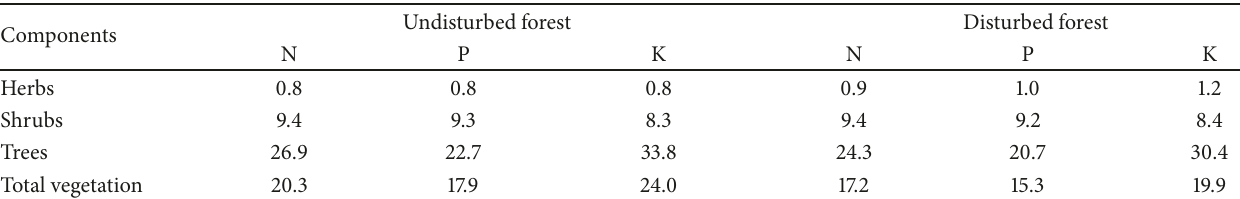
Table 10: Turnover time (year) for different nutrients in standing vegetation of undisturbed and disturbed stands of moist tropical forest in Sunsari district, eastern